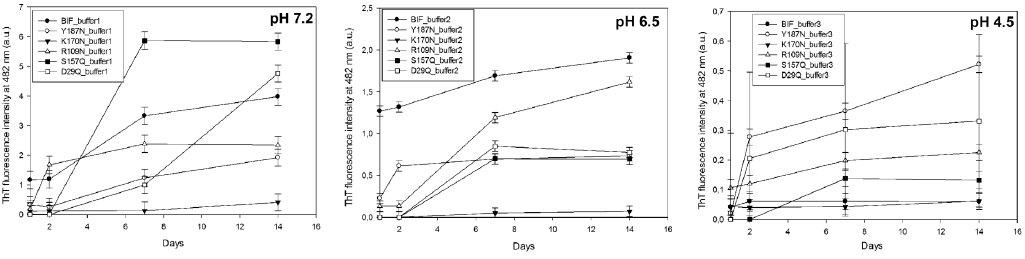
Figure 15. ThT fluorescence in presence of 1 μ g/mL protein at different pH.